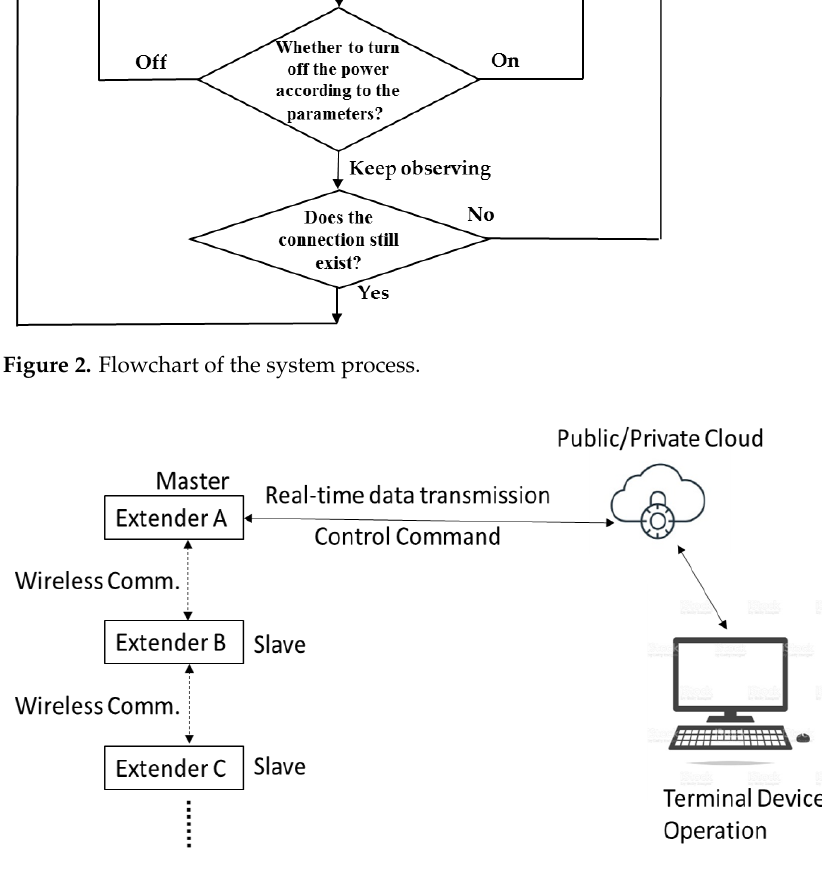
Figure 3. System architecture.